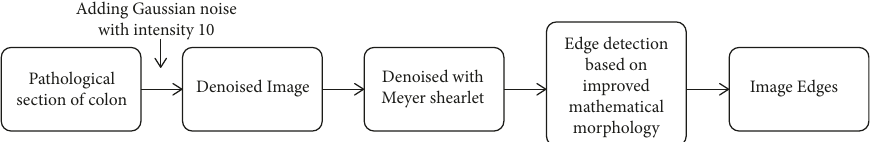
Figure 4: The image edge detection algorithm is based on edge